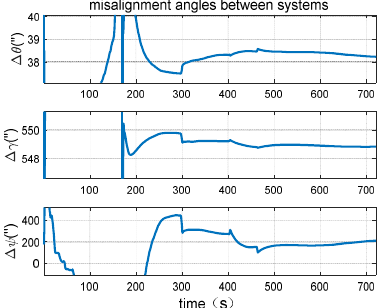
Figure 13. Dynamic calibration results of misalignment angles between systems.